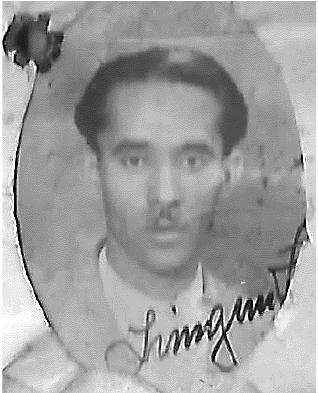
Figure 2. Dumitru Lingurar, 1948. Source: Corneliu